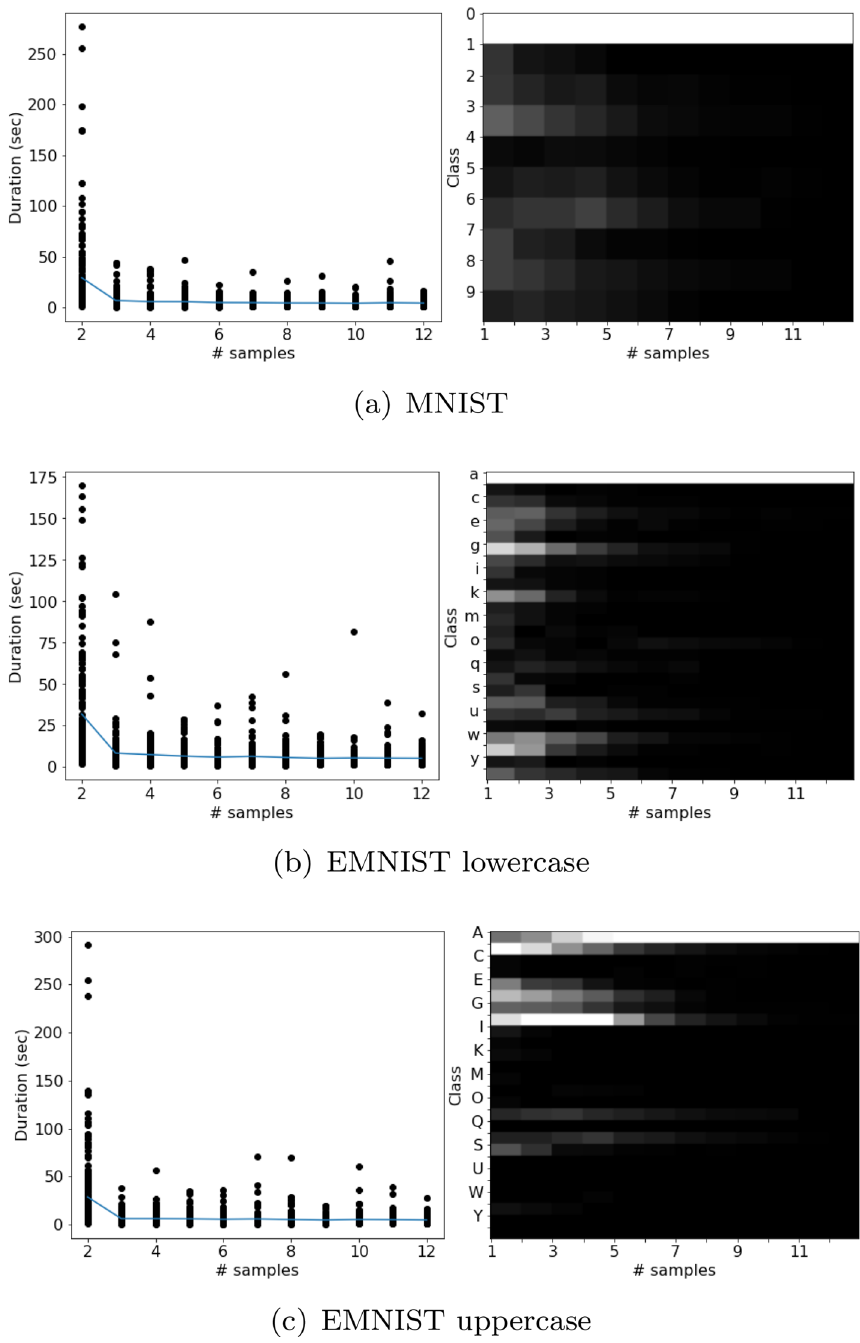
Figure 2. Duration and class distribution over all participants and stimuli belonging to categories ‘0’, ‘a’ and